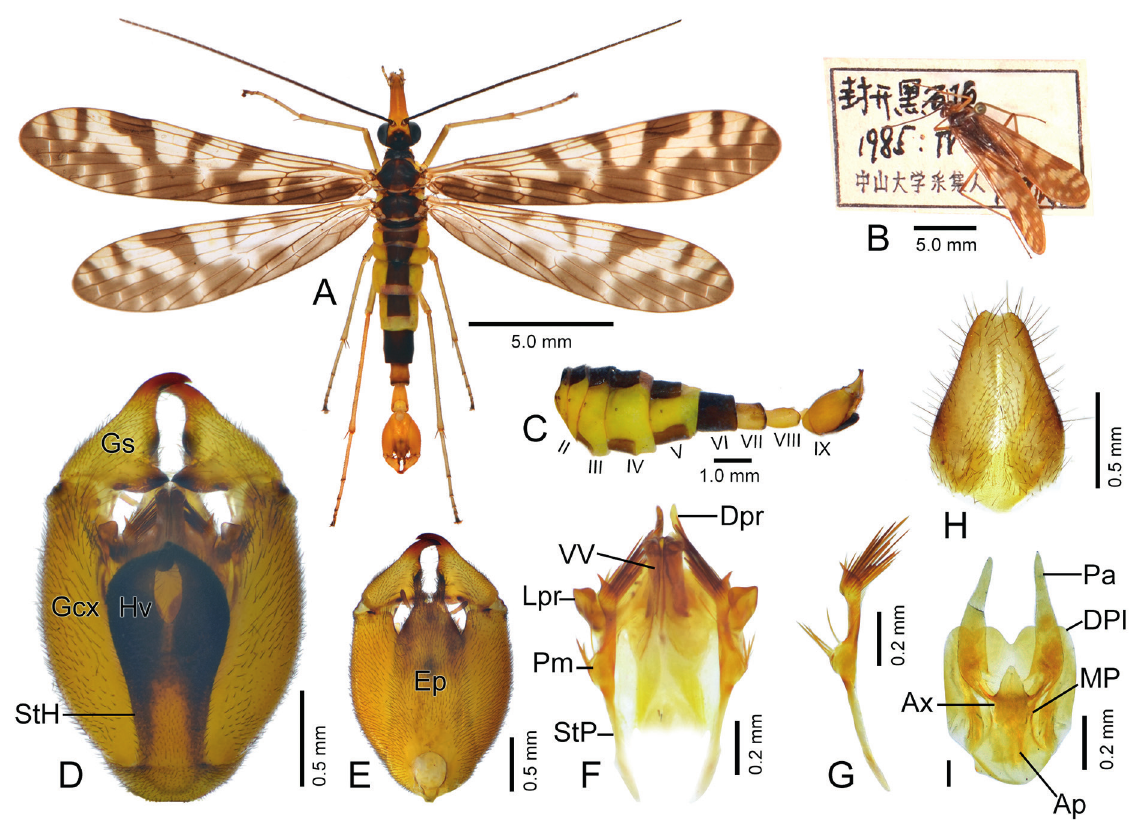
Fig. 5. Panorpa zhuohengi sp. nov. A , C – G . Holotype, ♂ (DALU). B , H – I . Paratype, ♀ (SYSU). A – B . Habitus, dorsal view. C . Abdomen, left-lateral view. D – E . Genital bulb, ventral and dorsal views, respectively. F . Aedeagal complex, ventral view. G . Left paramere, ventral view. H. Subgenital plate, ventral view. I . Medigynium, ventral